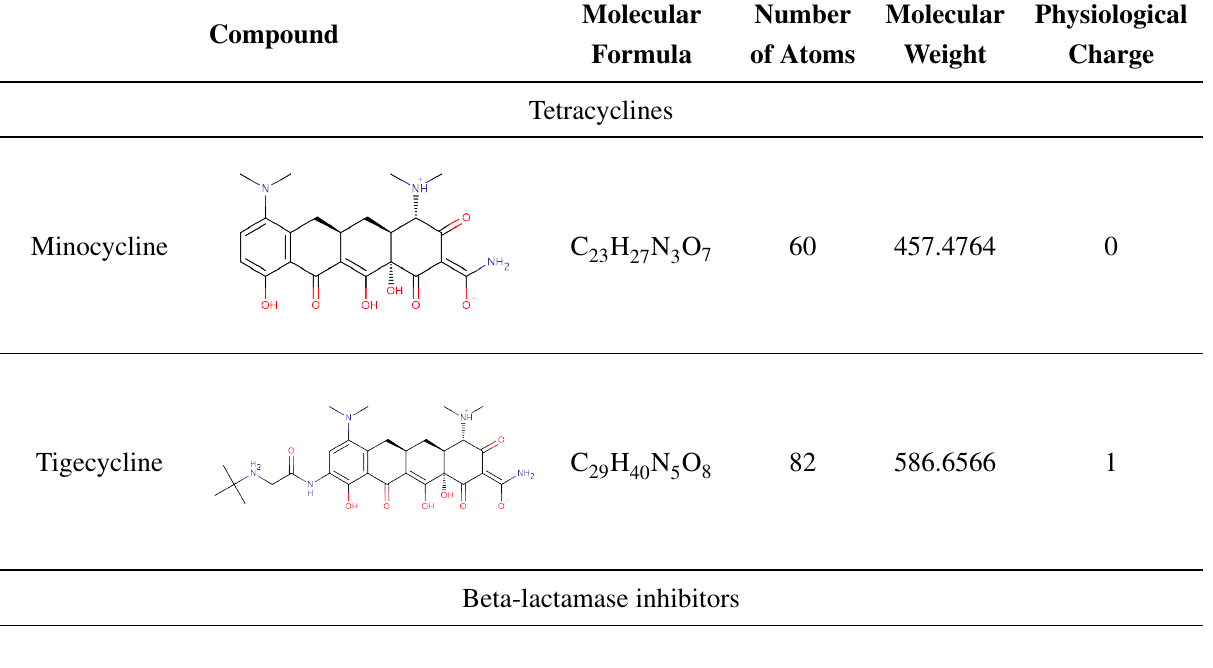
Table A1. Cont. Molecular Number Molecular Compound